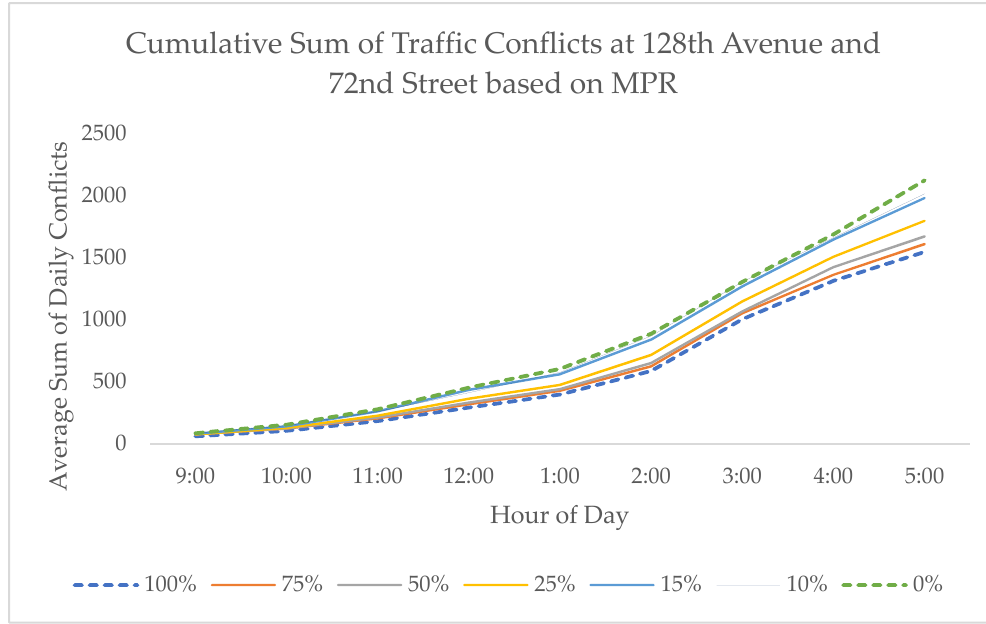
Figure 8. The effect of market penetration rate on conflict rate.